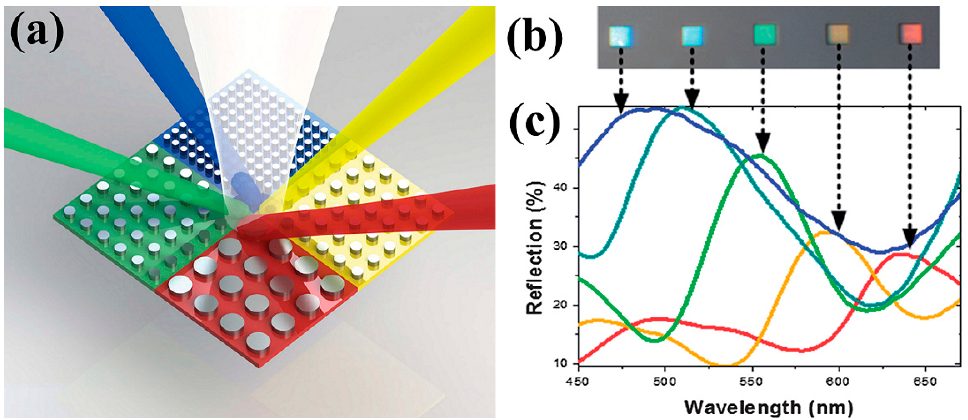
Figure 5. ( a ) Schematic drawing of silver nanorod color filters working under reflection mode; ( b ) optical image showing the reflective colors from different silver nanorod arrays; ( c ) measured reflection spectra of the corresponding arrays as a function of wavelength. All figures are adapted from reference [25].